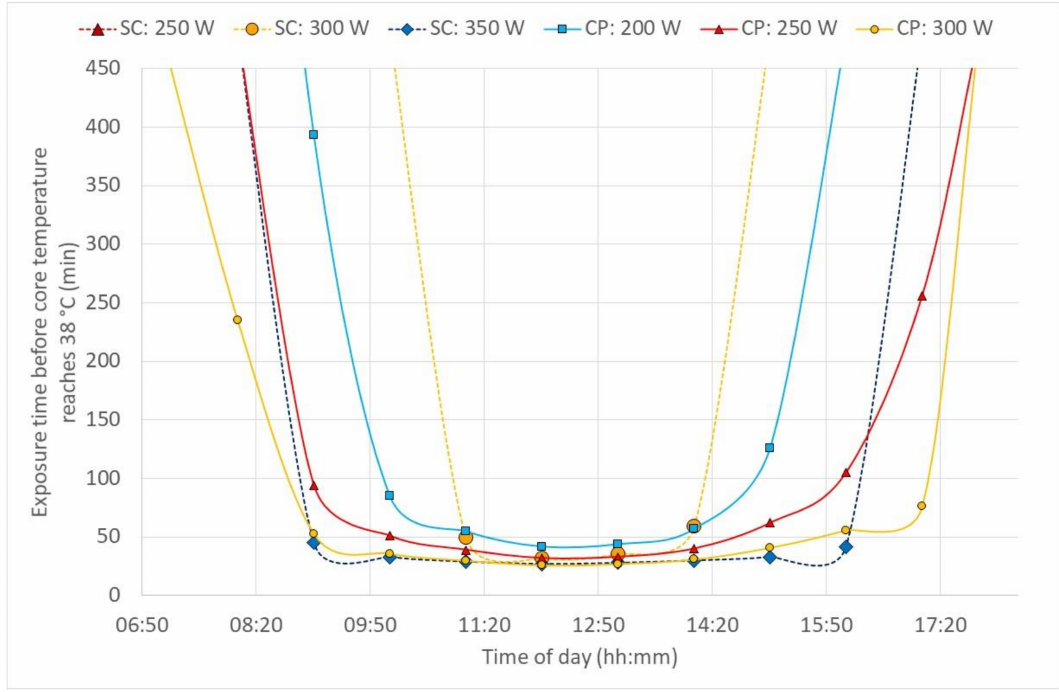
Figure 3. Expected daily duration limited exposure (DLE) for sugarcane cutters (SC) and chemical sprayers (CP) at various activity levels based on core temperature (criterion T rec < 38 ◦ C). At the lowest activity for sugarcane cutters (SC: 250 W), DLE was above 8 h (480 min), and therefore, the line cannot be seen in this